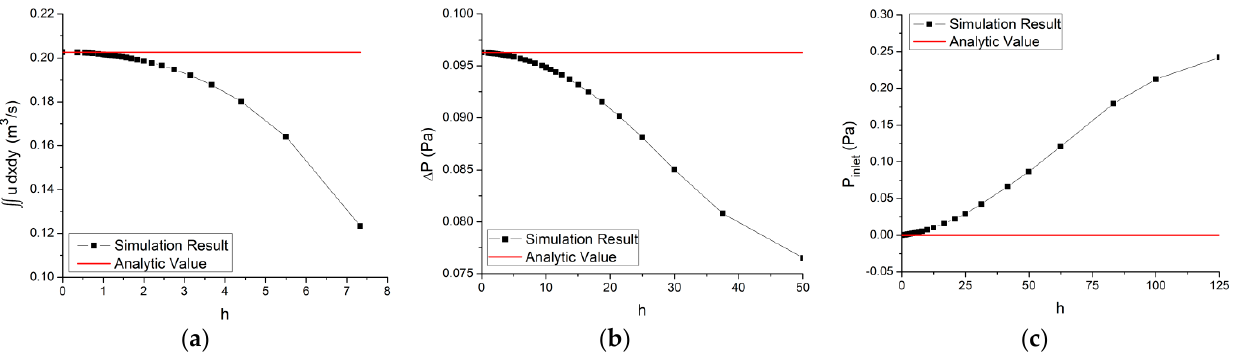
Figure 5. The MMS simulation result that fits condition A: ( a ) Case 3; ( b ) Case 6; ( c ) Case